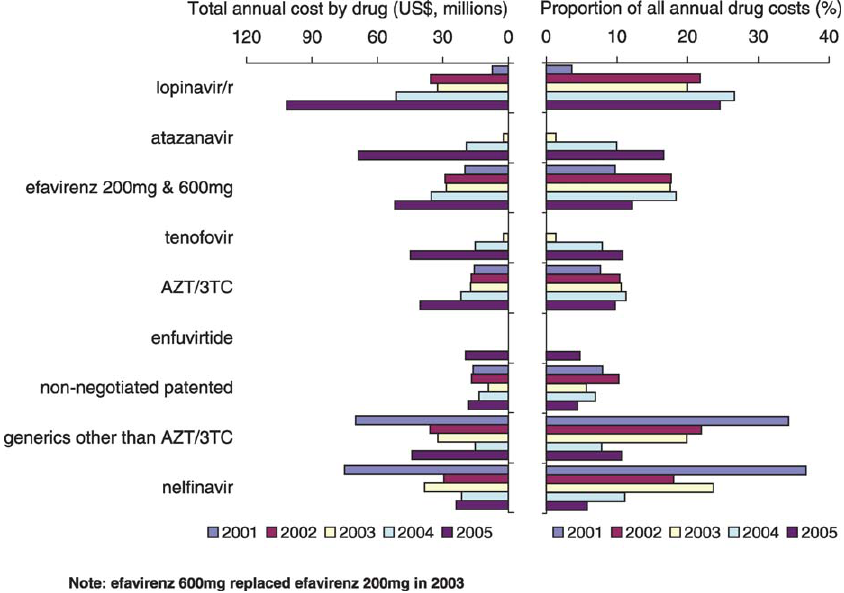
Figure 4. Total Annual Cost by Drug (Left) and Proportion of All Annual Drug Costs (Right)